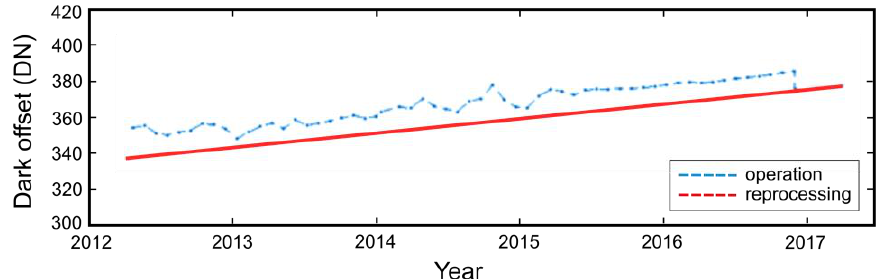
Figure 7. Trends in the operational DNB high-gain stage (HGS) dark offset (updated monthly) and the reprocessed DNB HGS dark offset (updated weekly) [54].